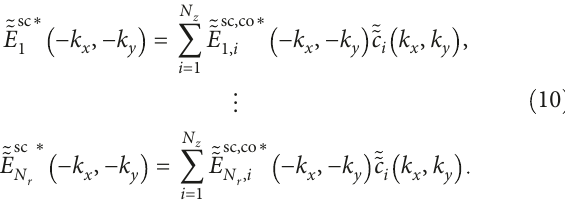
Figure 4: Reconstructed images when using 13 resonant dipole antennas. For this example, the parameters are z z =1.5 λ , d = λ , d =2 λ , s = λ /8, and D =0.25 λ . These results are 3 2 3 with SNR